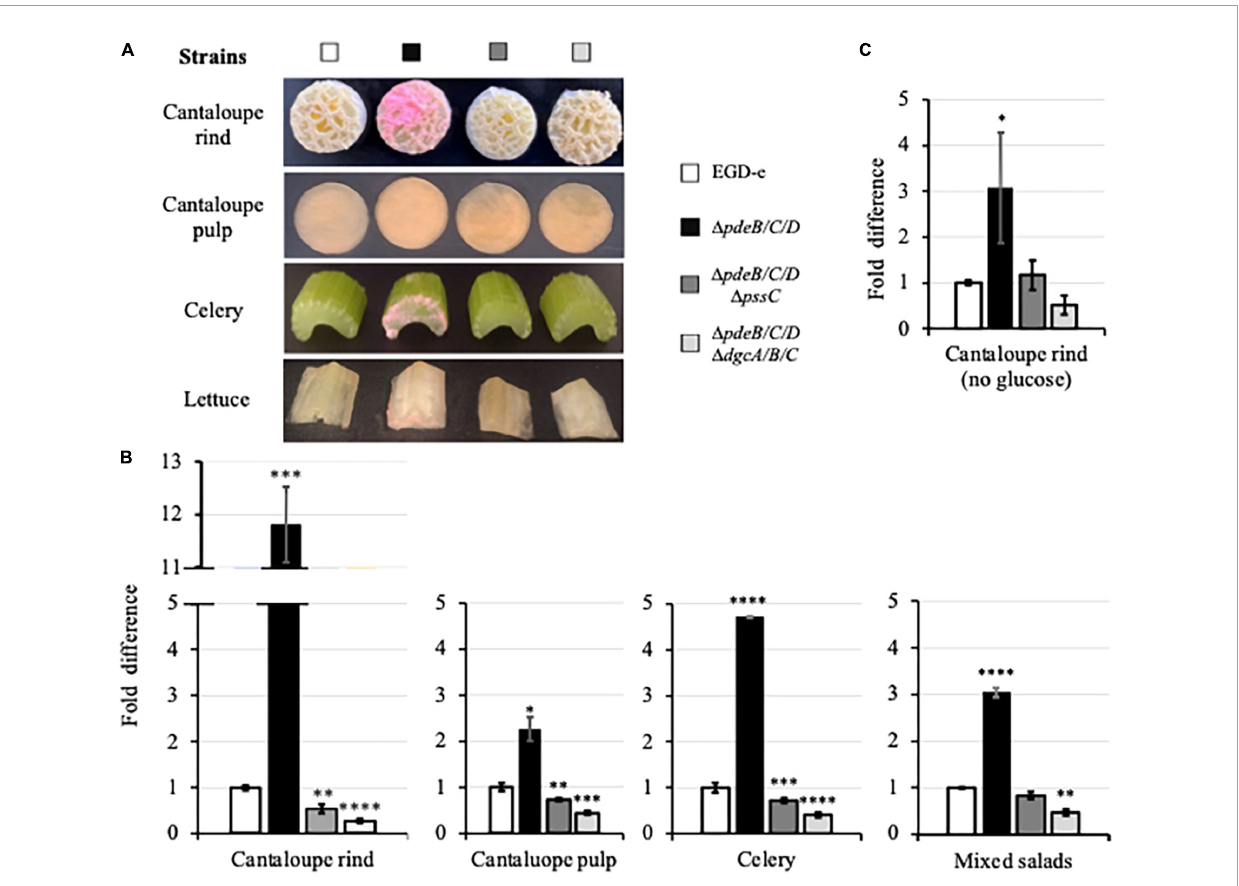
FIGURE3 The EPS-enhanced colonization of the pieces of fresh produce. (A) Pieces of cantaloupe (containing or lacking rind), celery and Iceberg lettuce (a component of mixed salad) following incubation in the HTM/GY medium with L. monocytogenes for 48 h at 30 ◦ C. The biomass appears pink due to the expressed mScarlet protein. (B) Comparison of the CFUs of L. monocytogenes in biofilms formed on the fresh produce pieces incubated in the HTM/GY medium. Shown are fold-differences compared to the wild type (EGD-e). The average CFU numbers for the wild type were 7.0 × 10 9 CFU per cantaloupe rind, 1.2 × 10 10 CFU per cantaloupe pulp, 1.9 × 10 8 CFU per piece of celery, and 8.0 × 10 8 CFU per three pieces (lettuce, carrot, cabbage) of mixed salad. Error bars represent standard deviations. (C) Comparison of the L. monocytogenes CFUs in biofilms formed on cantaloupe rind in the HTM medium lacking glucose and yeast extract. The average CFUs of the wild type was 7.4 × 10 6 CFU per cantaloupe rind. In all figures, data are from three independent experiments with at least two replicates in each experiment. Standard deviations are shown on the graph as error bars. Significant differences, compared to the wild type, are indicated as follows: * P < 0.05; ** P < 0.01; *** P < 0.001, and **** P < 0.0001.